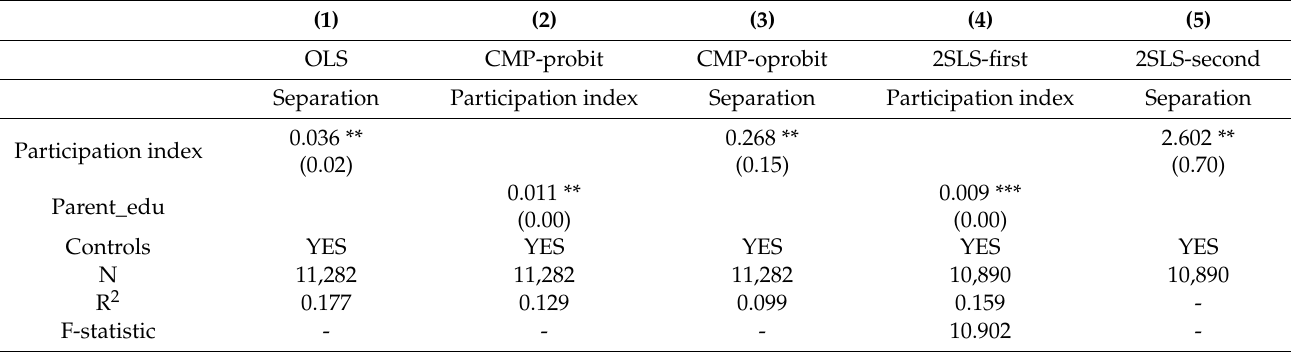
Table 5. Result of the instrumental variable